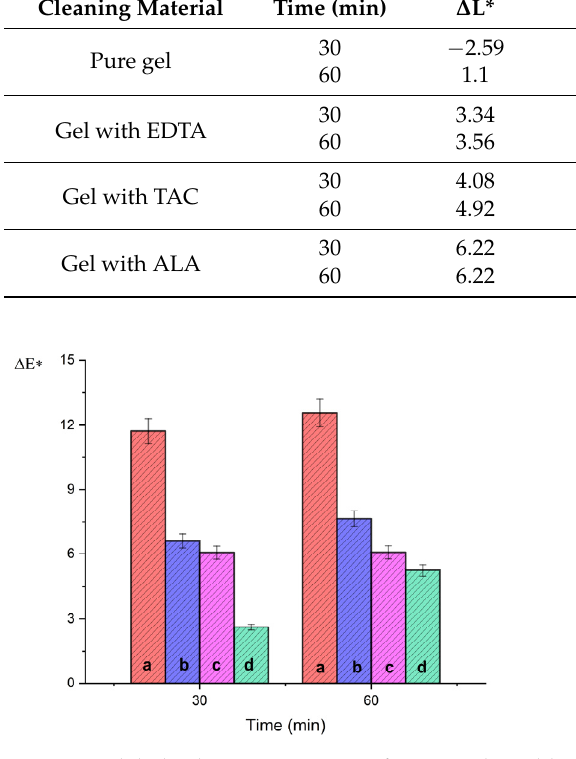
Figure 7. Global color variations ∆ E* for stained marble samples after 30 and 60 min contact with gels with ALA ( a ). with TAC ( b ), with EDTA ( c ), and of pure agar ( d ). For pure gels, the smallest global color variations ∆ E* were measured ( ∆ E* 2.61 and 5.25 after 30 and 60 min, respectively). These values are significant, since ∆ E* > 2 corre- sponds to a cleaning action perceivable by naked eye [41]. After cleaning with the gels with additions, higher ∆ E* values were measured, increasing in the order EDTA < TAC < ALA. This result confirms that added agar gels are more effective in removing copper